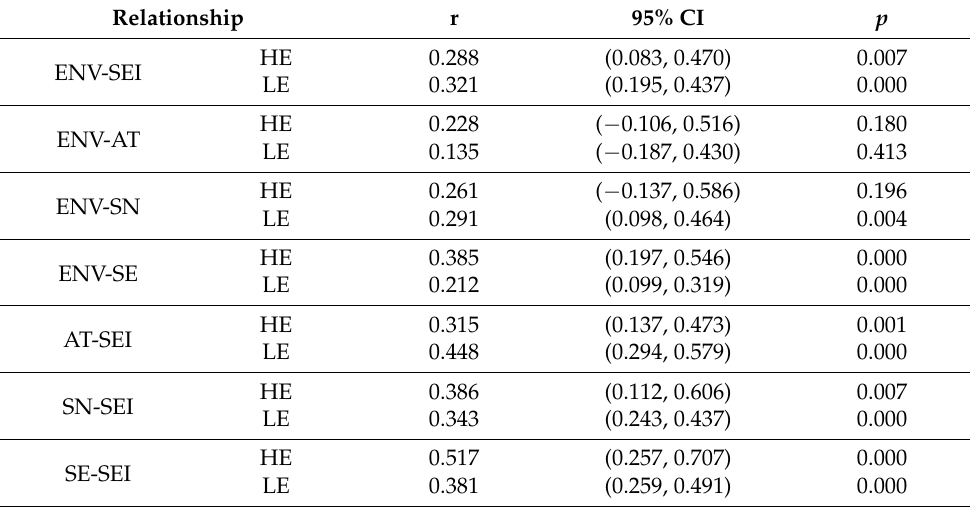
Table 4. Results of the moderator